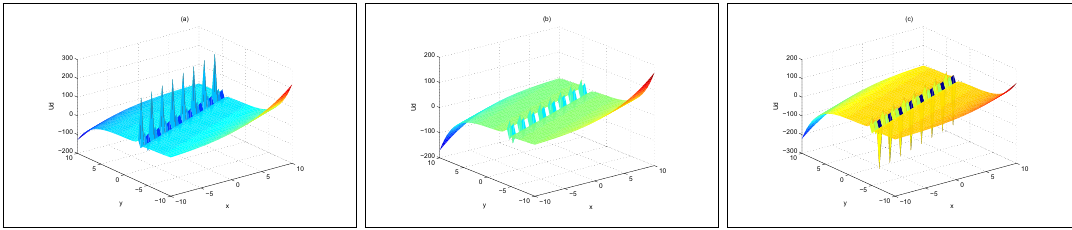
Figure 4: The solution of the ( 2 + 1 )- dimensional gCBS equation corresponding to ( ) U z d , ( a ) = t −3 , ( b ) = t 0 and ( c ) = t 3